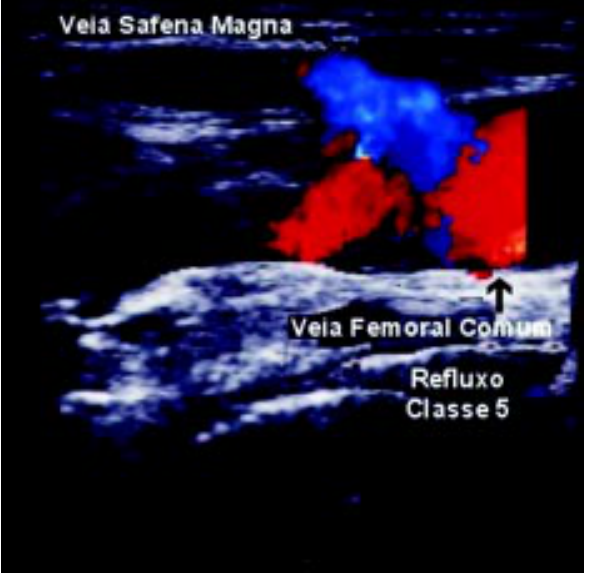
Fig. 4 - Selective iliac valvular regurgitation.